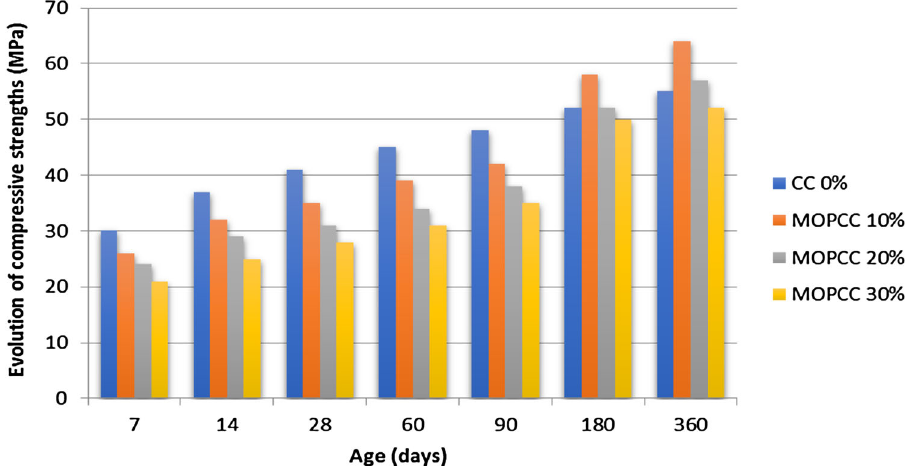
Fig. 8 Compressive strength of concretes in MPa, as a function of